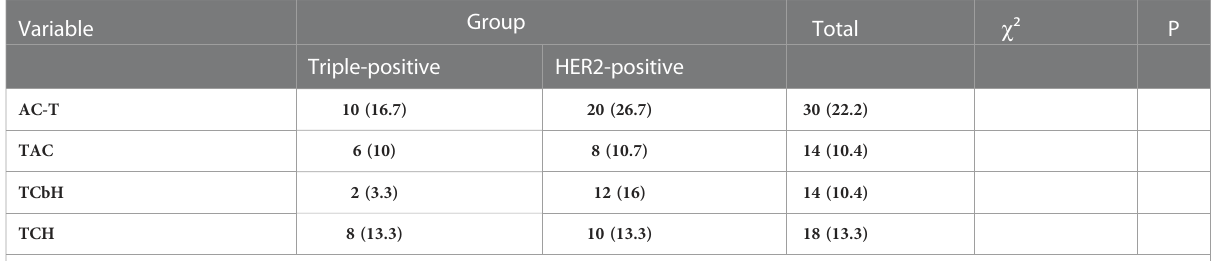
TABLE 2 Recurrence and metastasis of triple-positive breast cancer and HER2-positive breast cancer. Group